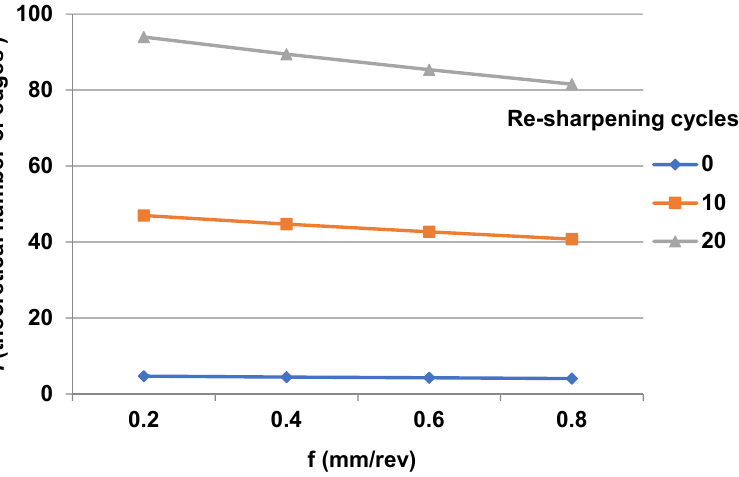
Figure 19. Influence of feed rate on edges using the δ = α + β strategy for application of r ε = 1.5 mm insert with a different number of resharpening cycles z.